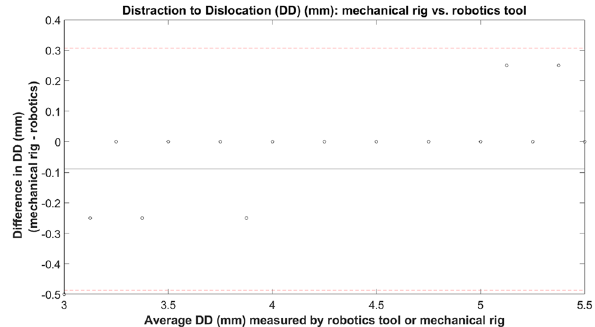
Figure 9. Bland–Altmann assessment for medial dislocation comparing mechanical rig versus robotics dislocation analysis